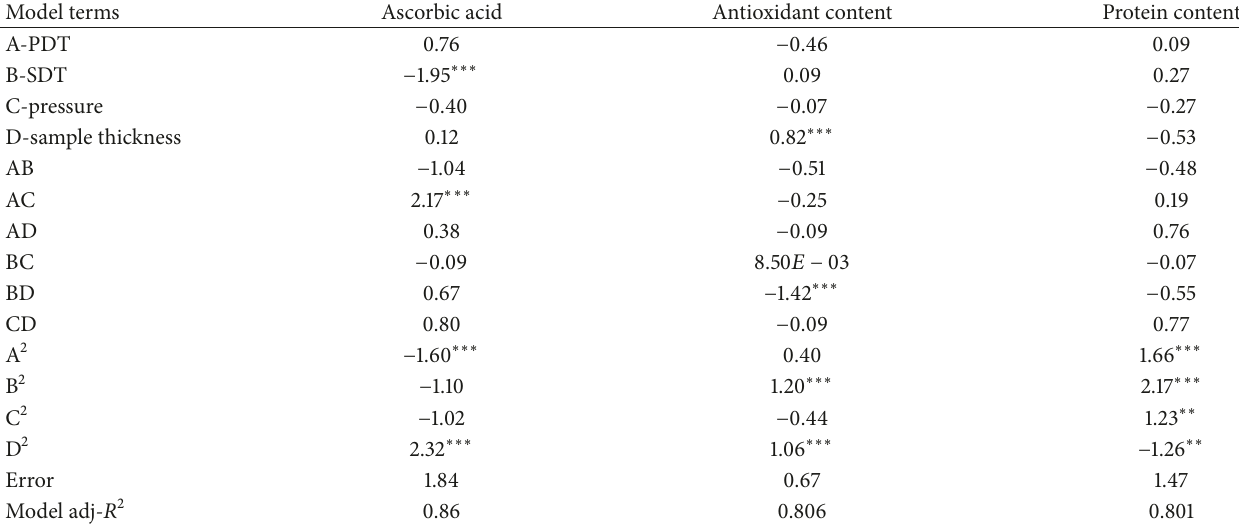
Table 2: Model coefficients generated by RSM.